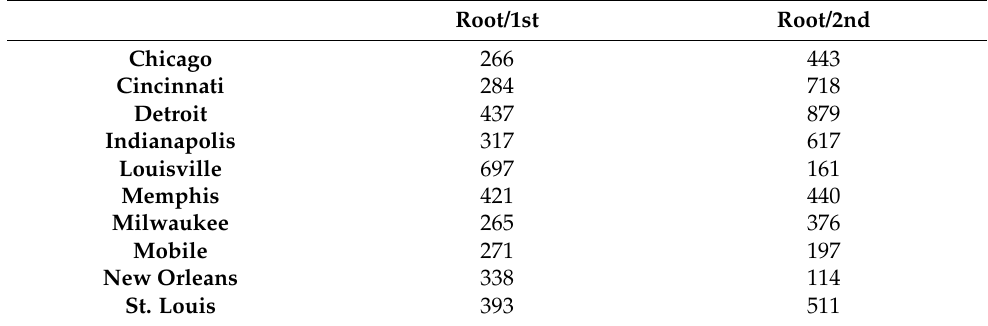
Table 2. Mean Migration Distance (MMD) by Generation Pair from those born in these Cities in 1850—Males Only (in miles).